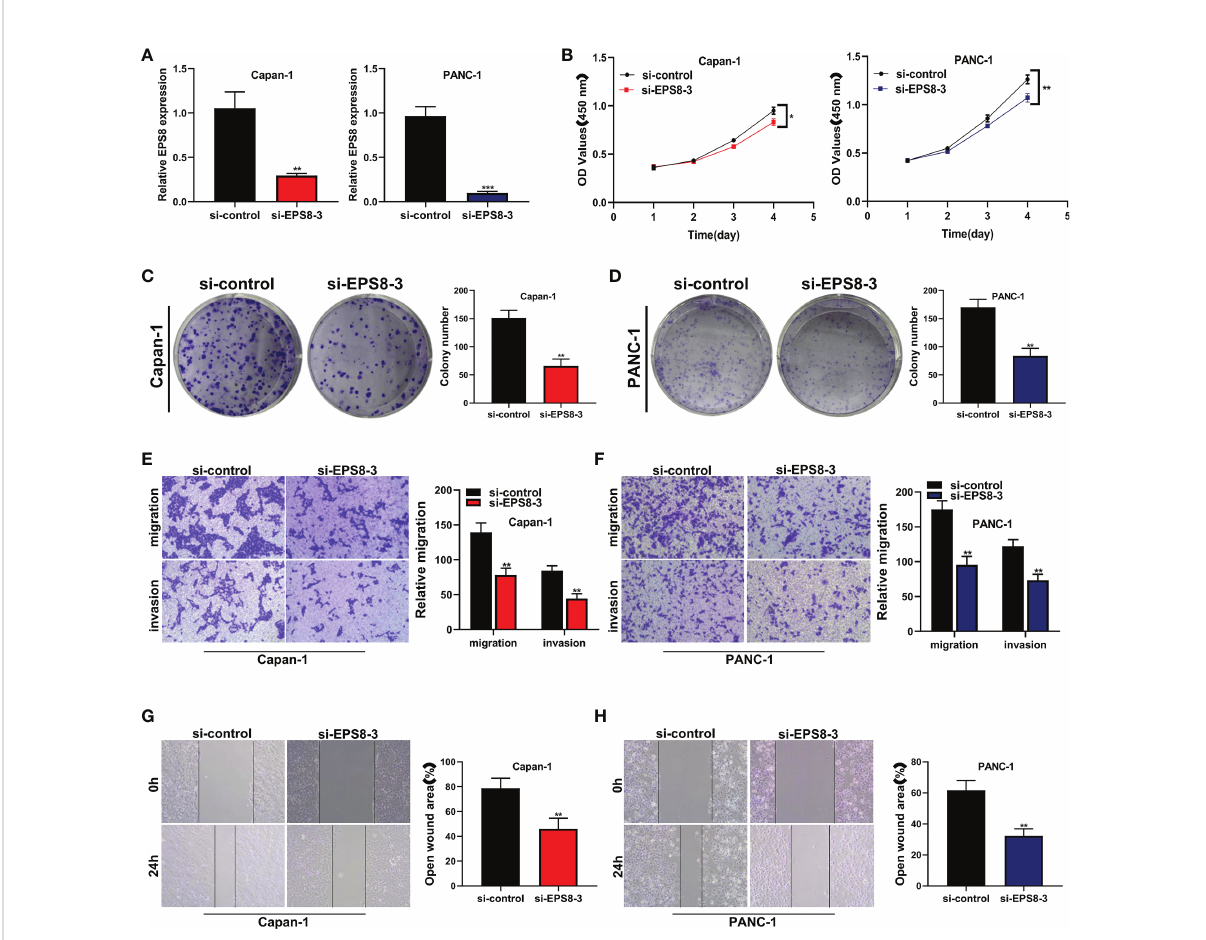
FIGURE 9 The role of the key gene EPS8 in pancreatic cancer cell lines was veri fi ed in vitro . (A) EPS8 was dramatically reduced In both the CAPAN-1 and PANC-1 cell lines (**P<0.01, ***P<0.001). (B) The activity of pancreatic cancer cells was dramatically reduced following EPS8 knockdown in CAPAN-1 and PANC-1 cell lines (*P<0.05, **P<0.01). (C, D) Clonal formation assays revealed that the ability of the CAPAN-1 cell line and the PANC-1 cell line to produce colonies was considerably reduced following EPS8 knockdown (**P<0.01). (E, F) EPS8 knockdown dramatically reduced the migration and invasion capacity of pancreatic cancer cells in the CAPAN-1 cell line and PANC-1 cell line in the transwell experiment (**P<0.01). (G, H) The migration ability of EPS8 group was weaker in si-EPS8 group in the wound healing experiment in the CAPAN-1 cell line and PANC-1 cell